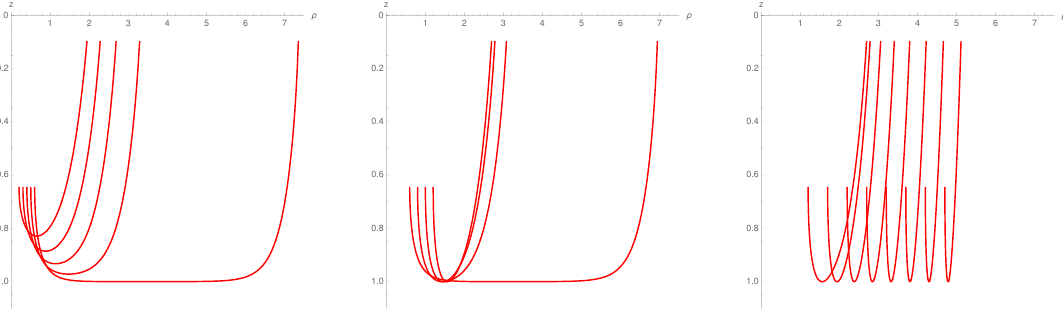
Figure 8 . Plots of the loops of type ( II ) for increasing values of the inner radius R 1 . The left panel shows region (i) until the value for which R 2 is maximal. The middle panel shows loops in region (ii), where R 2 decreases as R 1 increases, until R 2 reaches its local minimum. The right panel shows the squashed loops of region (iii) which occur beyond that.